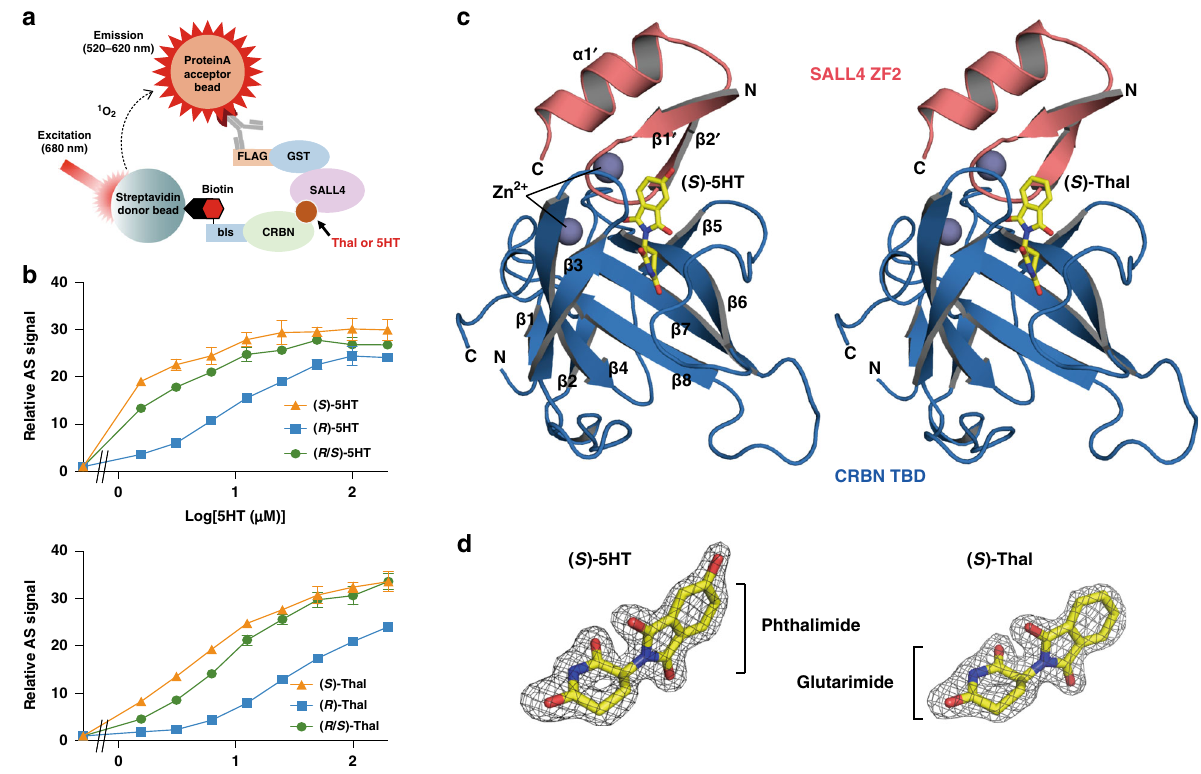
Fig. 1 The formation of the SALL4 and CRBN complex as mediated by ( S )-5HT or ( S )-thalidomide (Thal). a Schematic diagram of the AS-based interaction assay. b Dose-dependent formation of the SALL4 – CRBN complex, as determined by the titration of racemate or each enantiomer of 5HT (upper) or Thal (lower) in the AS-based assay. AS signals are expressed as the luminescence signal relative to the luminescence signal of DMSO, which is considered equal to one. Data are presented as mean values± standard deviation (SD) ( n = 3 independent experiments). c Crystal structures of the ternary complex of CRBN TBD (blue) and SALL4 ZF2 (salmon) mediated by ( S )-5HT (left) or ( S )-Thal (right), which are shown by yellow sticks. Two zinc ions (Zn 2 + ) are represented by the gray spheres in each complex. Secondary structural elements of CRBN TBD and SALL4 ZF2 are labeled in the ( S )-5HT- mediated complex. d The structures of ( S )-5HT (left) and ( S )-Thal (right) in the SALL4 – CRBN complex. The F o ‒ F c omit map is shown by a mesh diagram at a contour level of